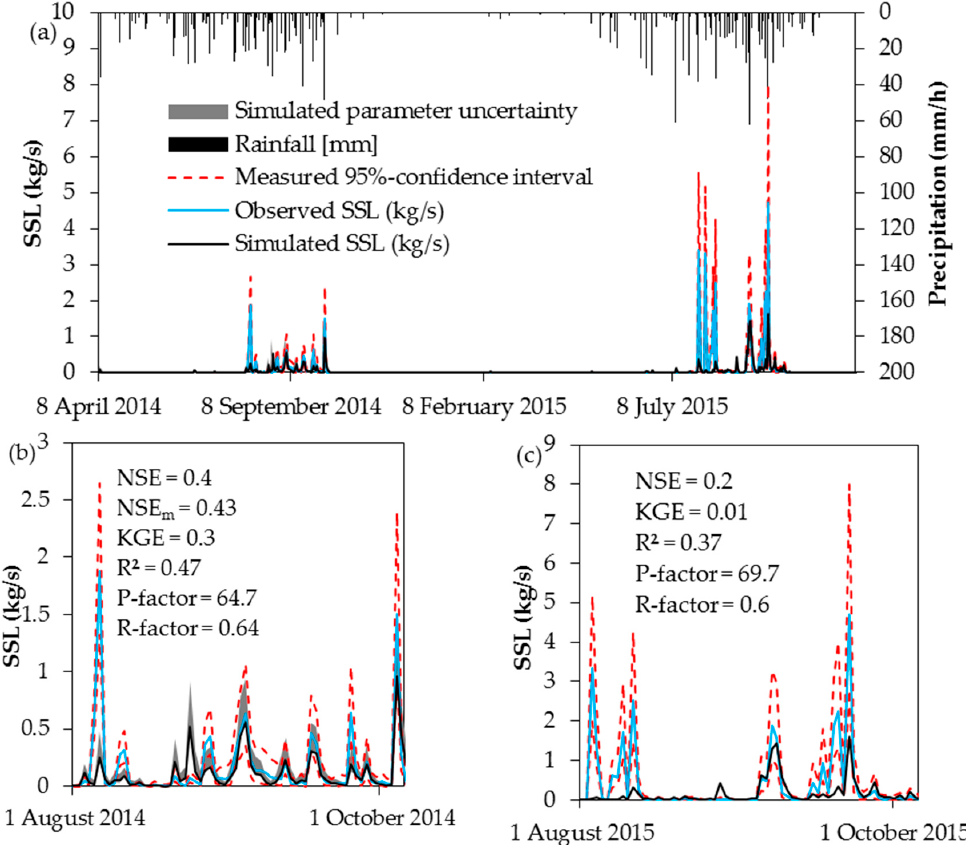
Figure 5. Observed and simulated daily suspended sediment load (SSL) over the calibration and validation period ( a ); and a selected period for the calibration ( b ); and validation ( c ) period. Measurement uncertainty is given for both periods, parameter uncertainty only for the calibration.